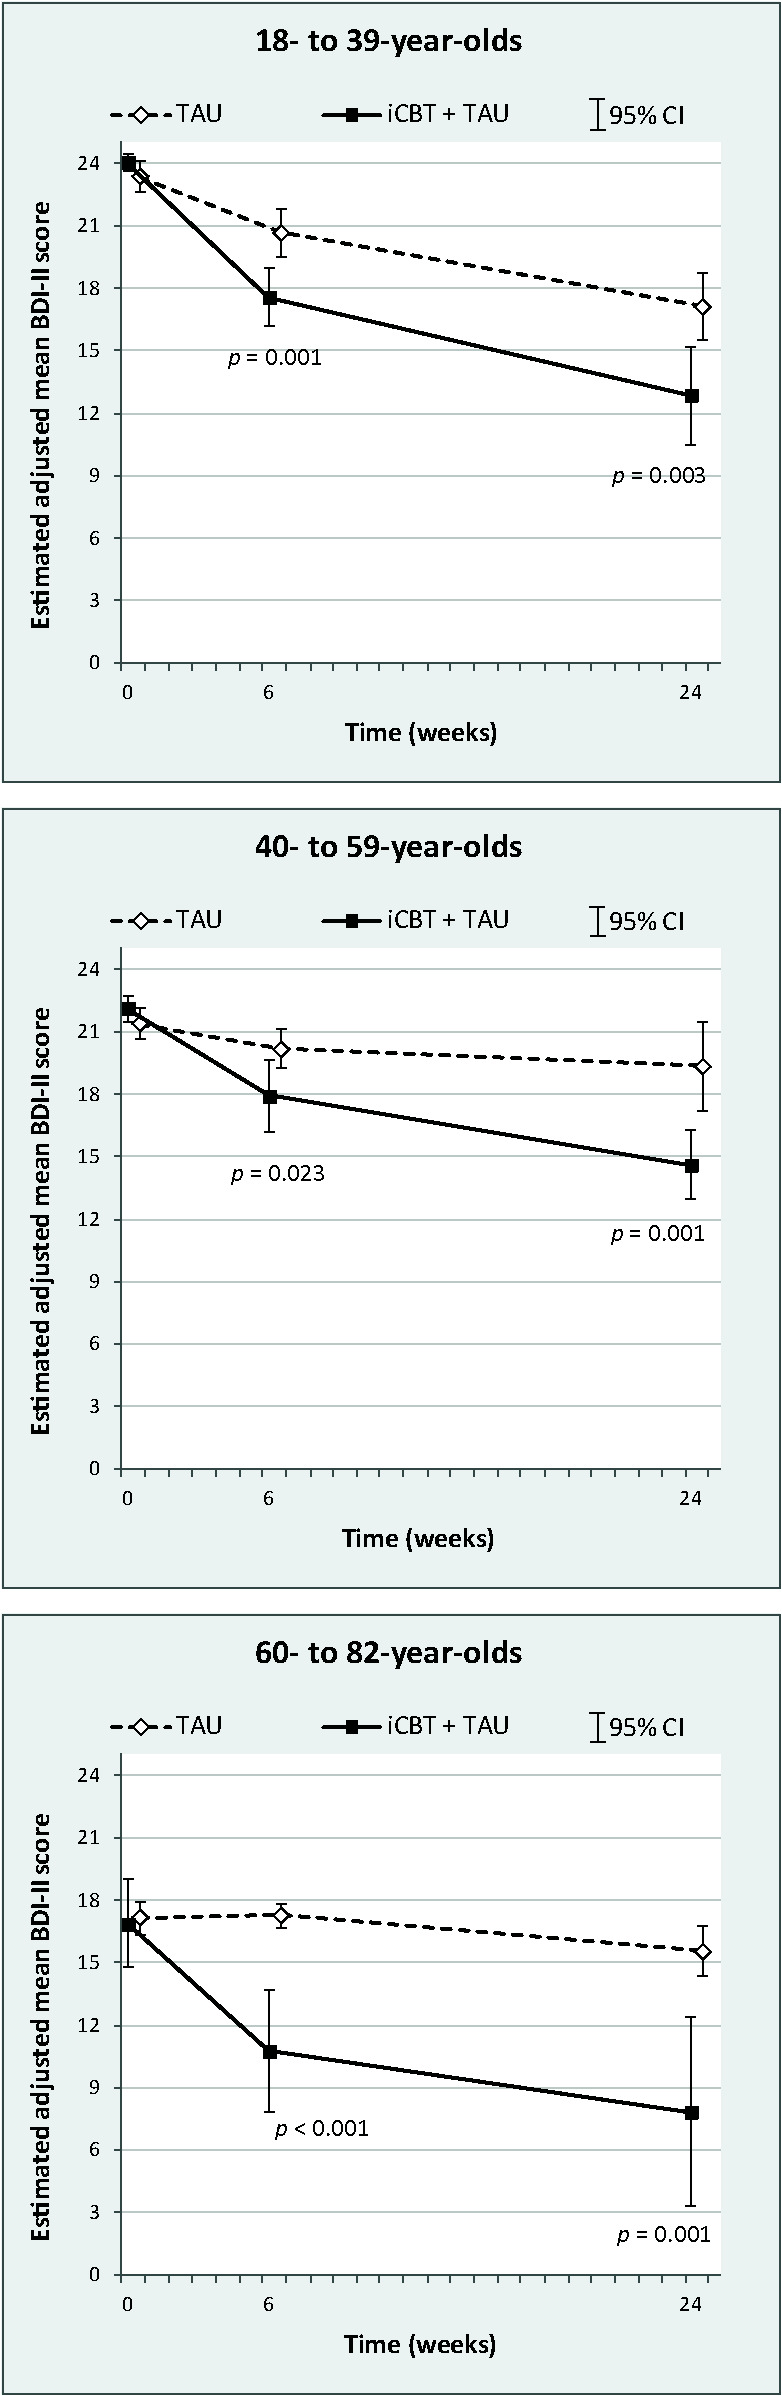
Estimated adjusted mean BDI-II scores with corresponding 95% confidence intervals by study group and time, and stratified by age. P-values for comparison of scores between groups at follow-up.